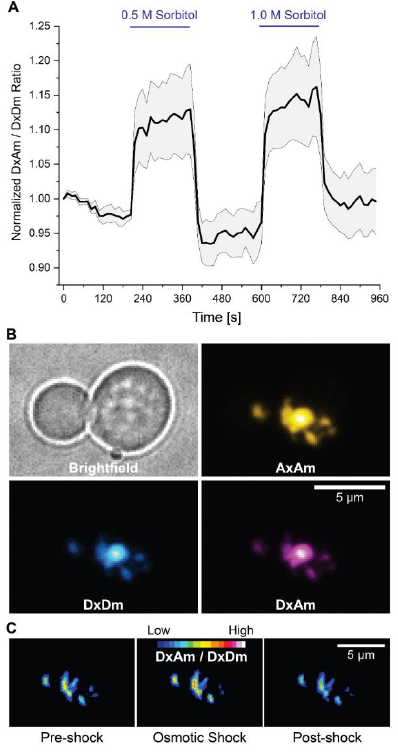
Figure 6. Quantitative fluorescence microscopy of yeast cells expressing OzTrac-MSL10-34. ( A ) Quantification of DxAm/DxDm ratio in trapped yeast cells exposed to square pulses of 0.5 or 1.0 M sorbitol (blue bars). Black line: mean ( n = 5 different cells). Shaded region: SEM. ( B ) Example images of brightfield, AxAm, DxDm, and DxAm channels. Fluorescence images shown in “Hot” pseudocolor lookup tables (ImageJ). ( C ) Representative example of ratiometric (DxAm/DxDm) response from aggregates. A 16-color lookup table and a binary mask from AxAm channel were applied (see Materials and methods for details). Comparable results were obtained from 4 independent experiments.